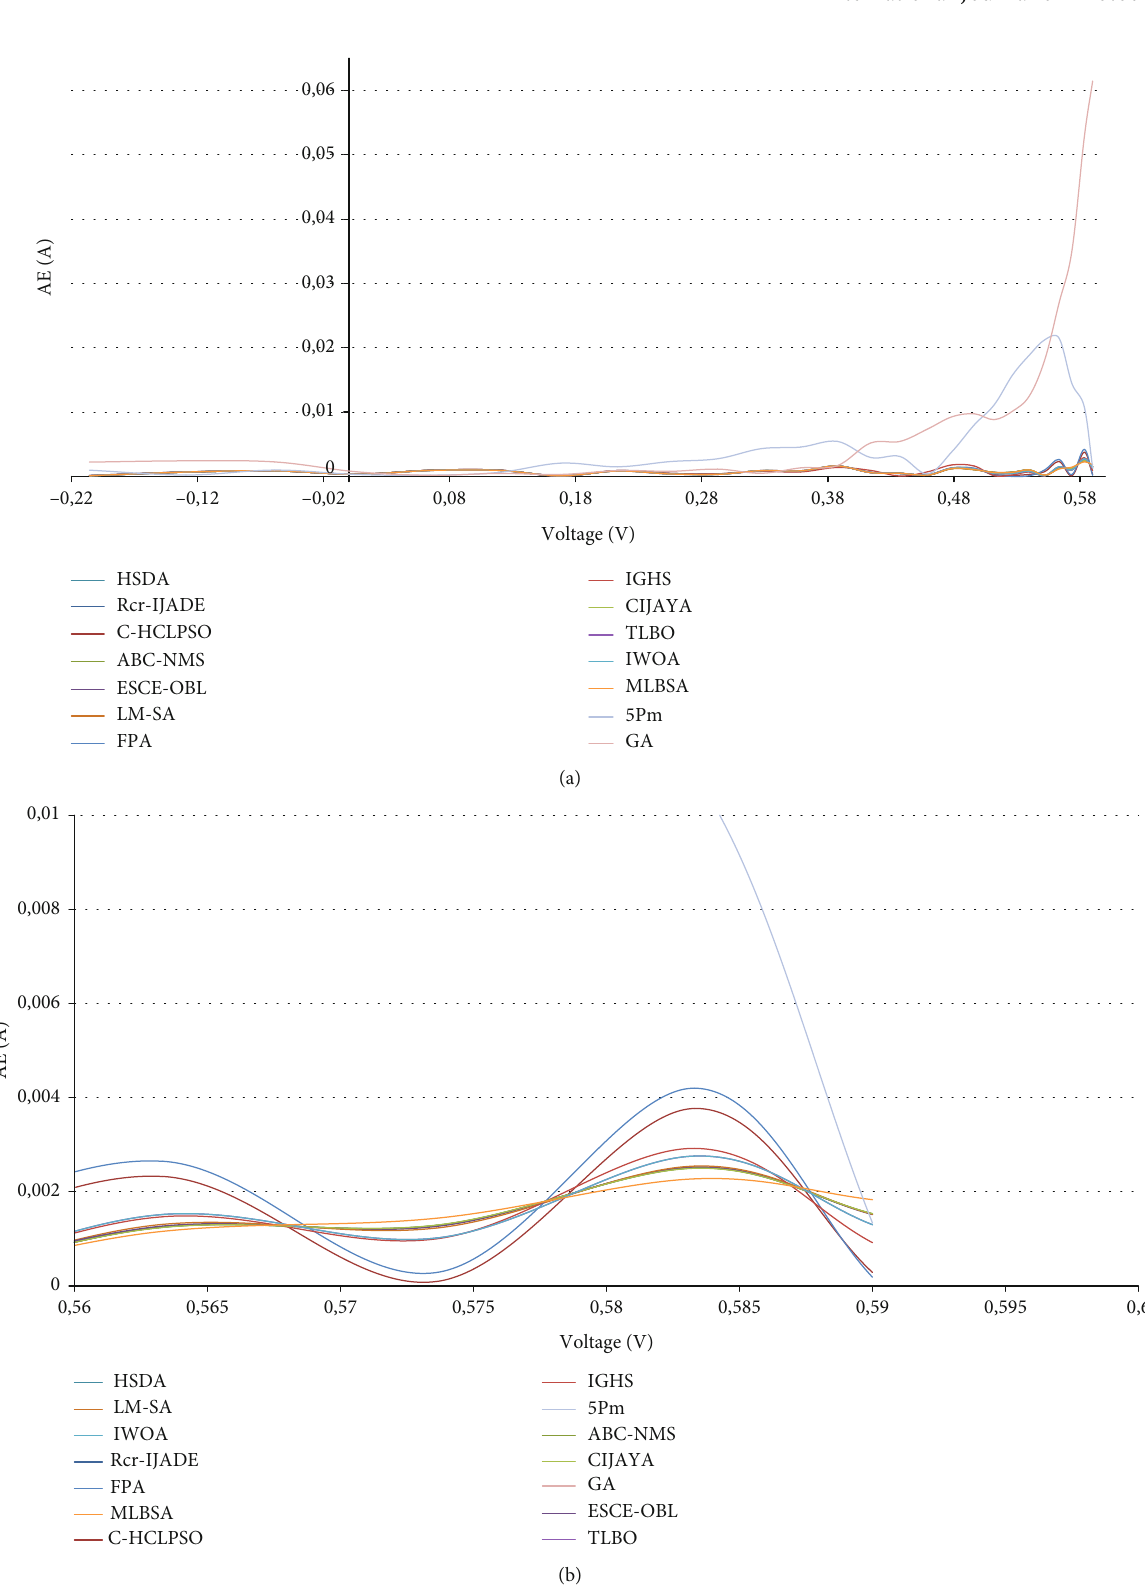
Figure 3: (a) The absolute current error (AE) for RTC France solar cell; (b) AE in open-circuit voltage